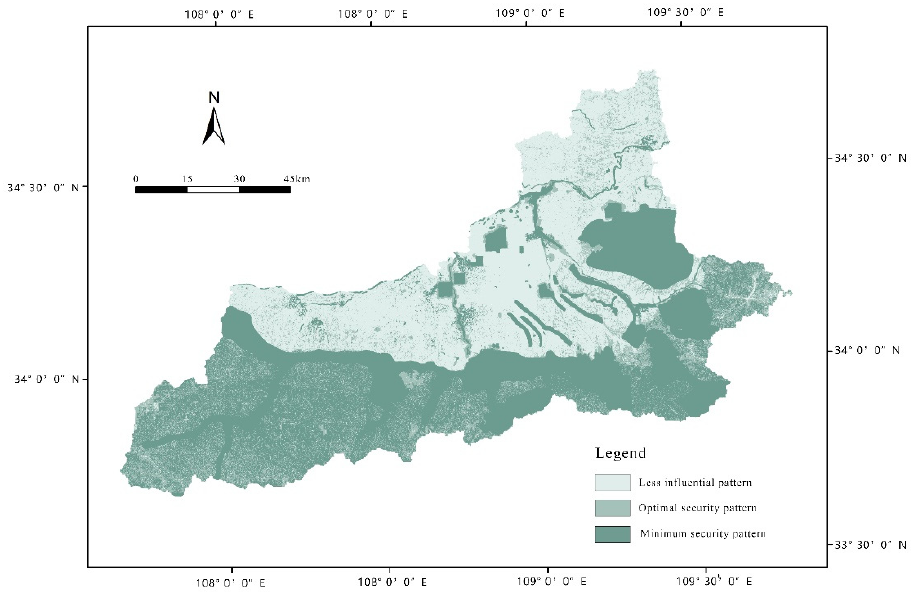
Figure 7. Integrated landscape security pattern.